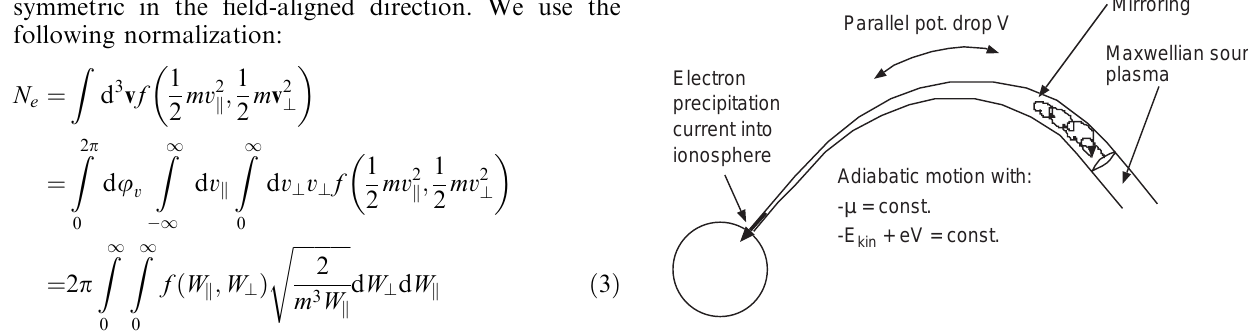
Fig. 1. Schematic description of the kinetic electron model. A Maxwellian source plasma is assumed to be maintained at a high magnetospheric region. Downward of that the first adiabatic invariant l (cid:136) W ? = B and particle energy are conserved. Particles that hit the ionosphere are assumed to be lost and they form the